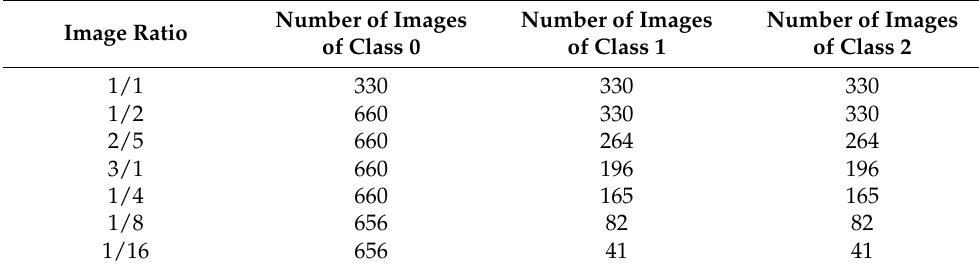
Table 2. Distribution of images considered in Experiment 2. Number of Images Image Ratio of Class